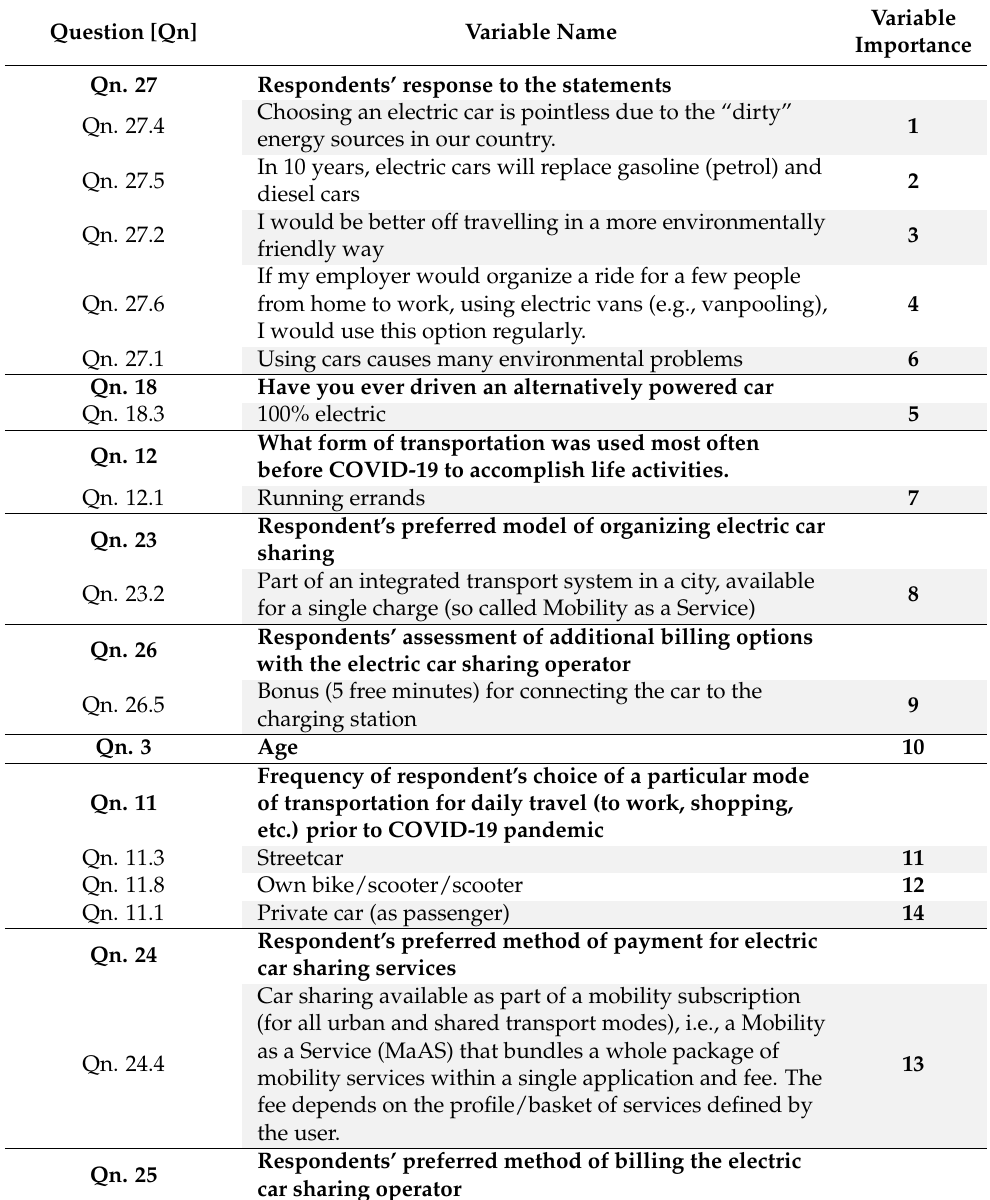
Table 6. Description of the relative importance of the variables in the final Random Forest model with variable